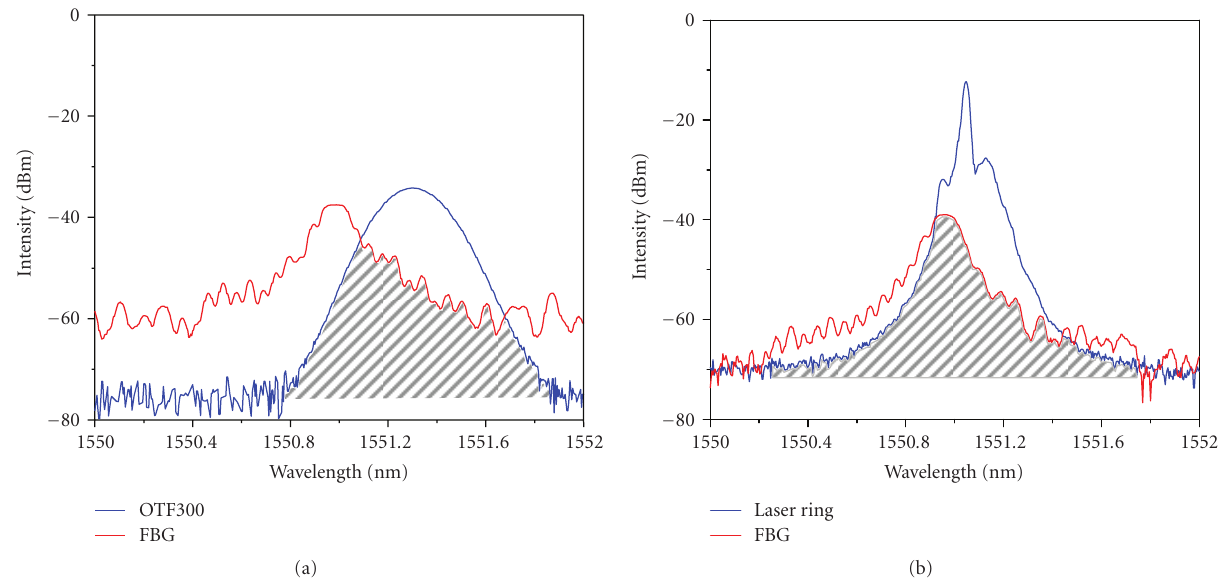
Figure 3: Relative spectra between the light source and the sensing FBG for schemes involving (a) an ASE source modified with an edge filter, (b) a laser ring